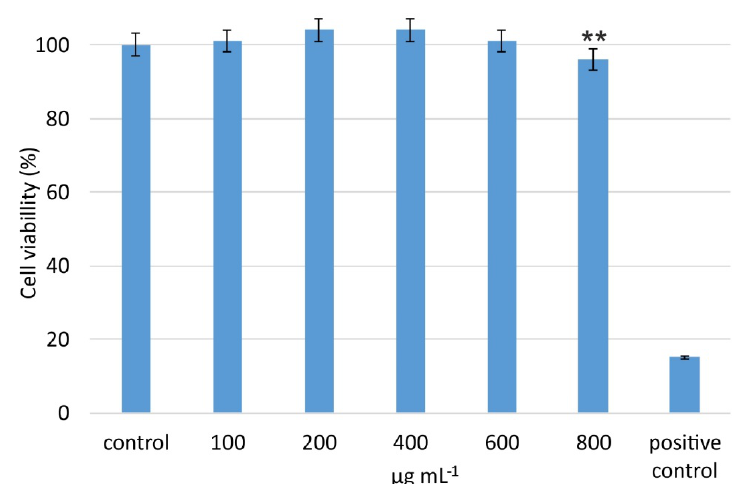
Figure 7. % Viability of HaCaT cells after incubation with CNDs-DS for 24 h; No statistically significant differences were recorded between control and cells treated with concentrations 100–600 μg mL −1 , while between control cells and cells treated with 800 μg mL −1 there is a statistically significant difference at p < 0.01 (**); positive control: treatment with H 2 O 2 100 μΜ .